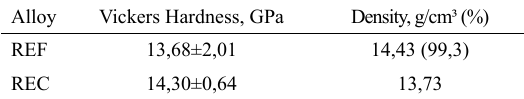
Table 1: Vickers Hardness and density of alloys REF and REC sintered at 1200ºC for 5 minutes, and heating rate of 160ºC/min. value in brackets is a relative density.